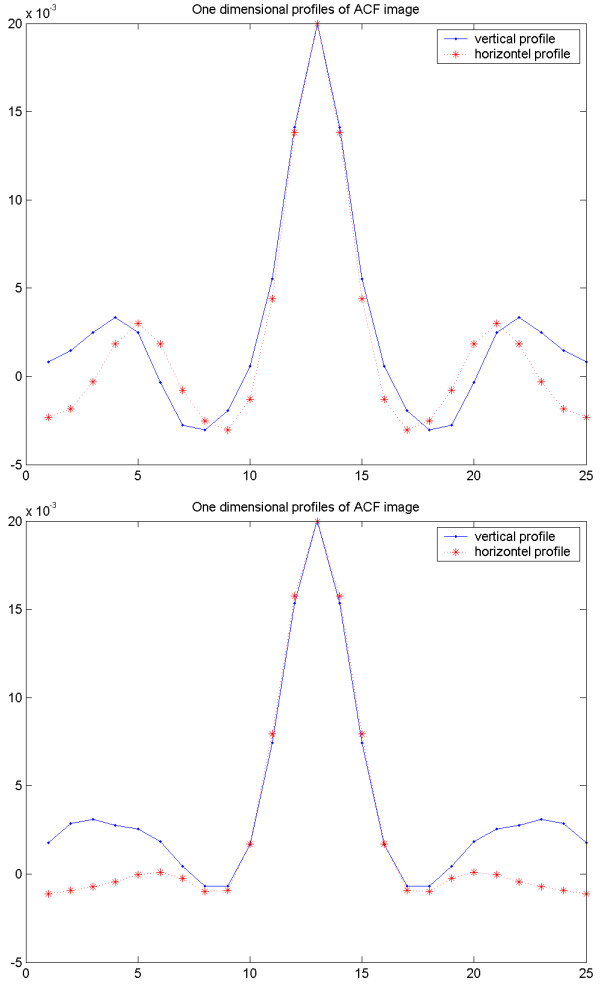
Results of the cylindrical NEMA phantom study. Vertical (dash point) and horizontal profile (dash star) through the centre of the ACF image from 2D (upper) and 3D acquisitions (lower) reconstructed using OSEM with 6 mm Gaussian filter.